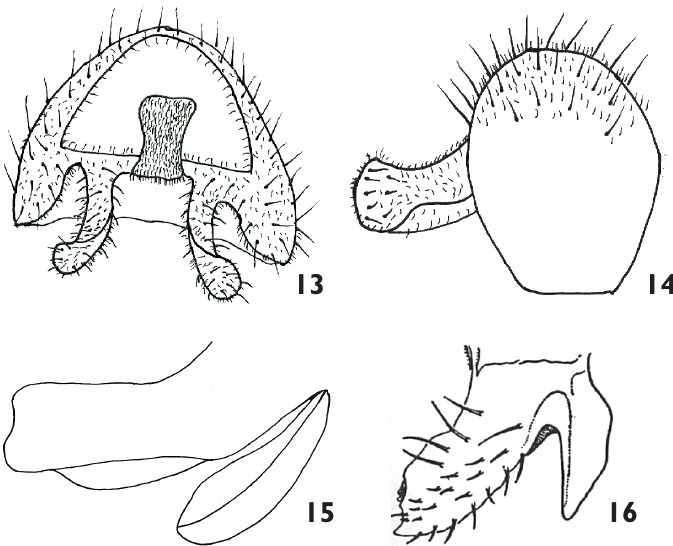
Figure 13–16. Meromyza samsunensis sp. n. (holotype): 13 epandrium, posterior view 14 epandrium, lateral view 15 postgonite, lateral view 16 Meromyza femorata : postgonite, lateral view (after Nartshuk and Fedoseeva,